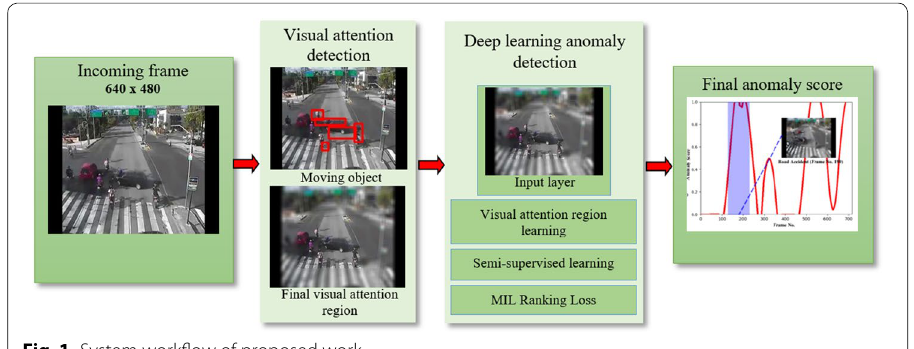
Fig. 1 System workflow of proposed